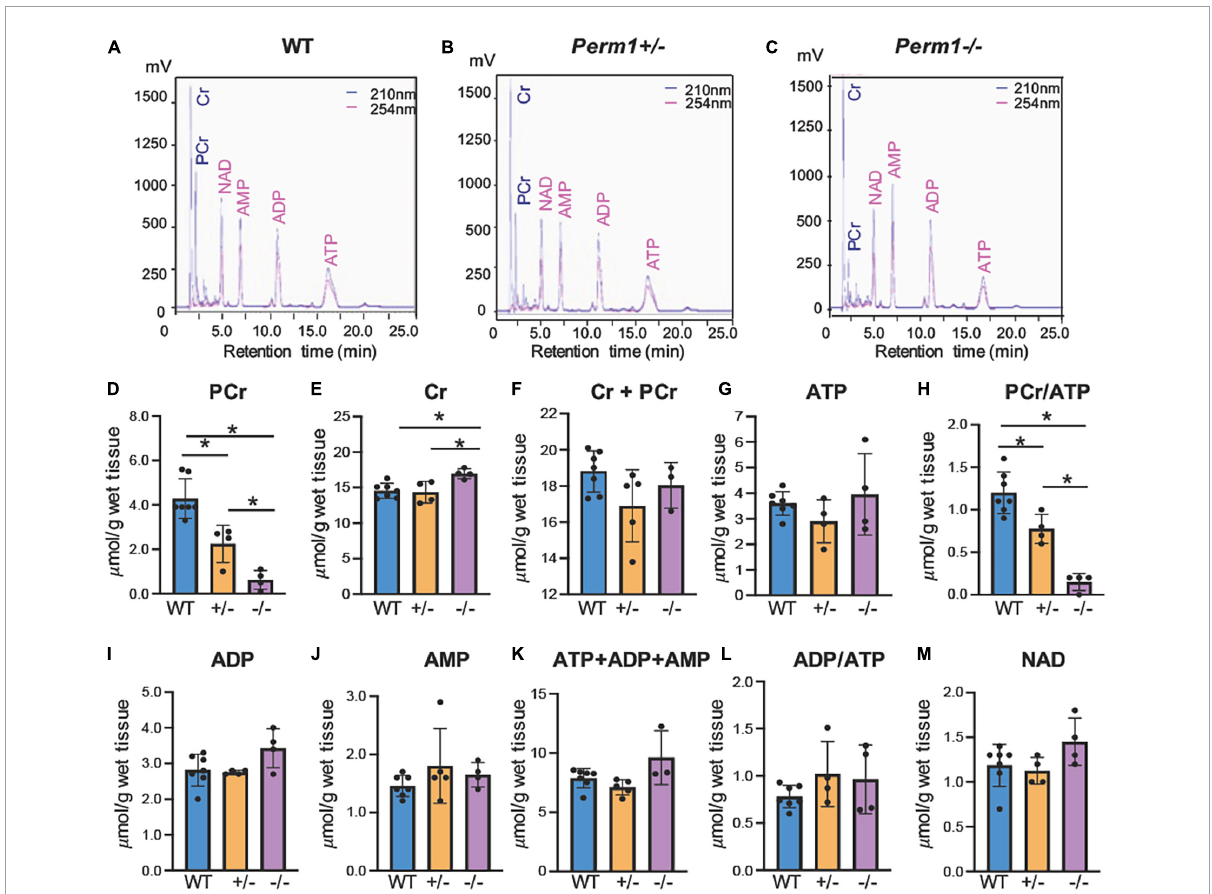
FIGURE2 Quantification of high-energy phosphates and related adenine nucleotides. Metabolites were measured by HPLC in ventricular tissue from WT, Perm1 ± and Perm1 − / − mice. Chromatograms of extracts from WT (A) , Perm1 ± (B) and Perm1 − / − hearts (C) . (D–M) Quantitative analysis of the levels of creatine (Cr), phosphocreatine (PCr), ATP, ADP, AMP, and NAD + , respectively, normalized by wet tissue weight. * p <